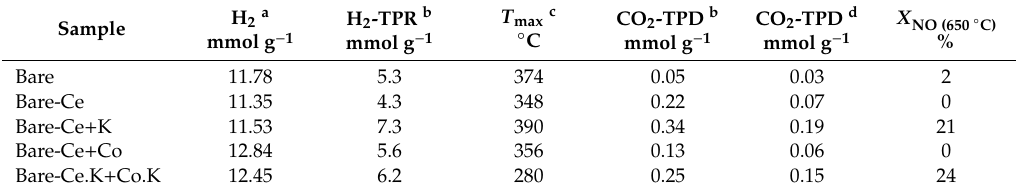
Table 3. H 2 -TPR, CO 2 -TPD data and NO conversions at 650 °C obtained for the examined catalysts.